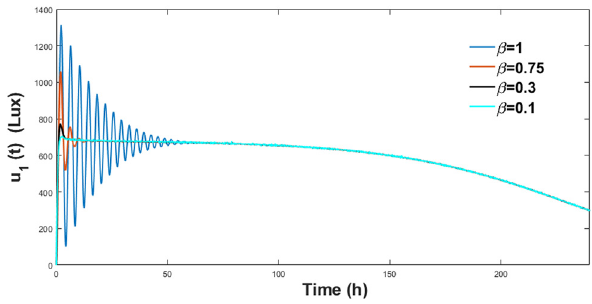
Figure 11: Comparison input u 1 ( t ) of the four di ff erent controllers with a change in the β